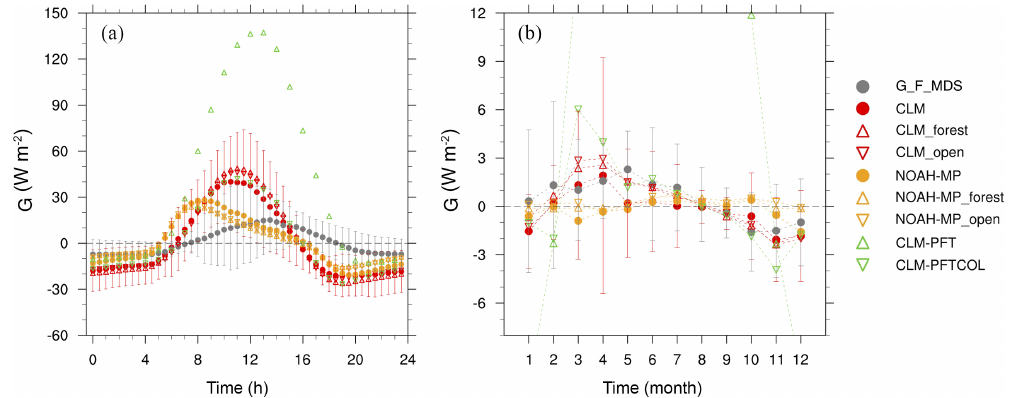
Figure 9. Change in the summer diurnal (a) and seasonal (b) cycles of R net (Wm − 2 ) due to LULCC from forest to open land (open −